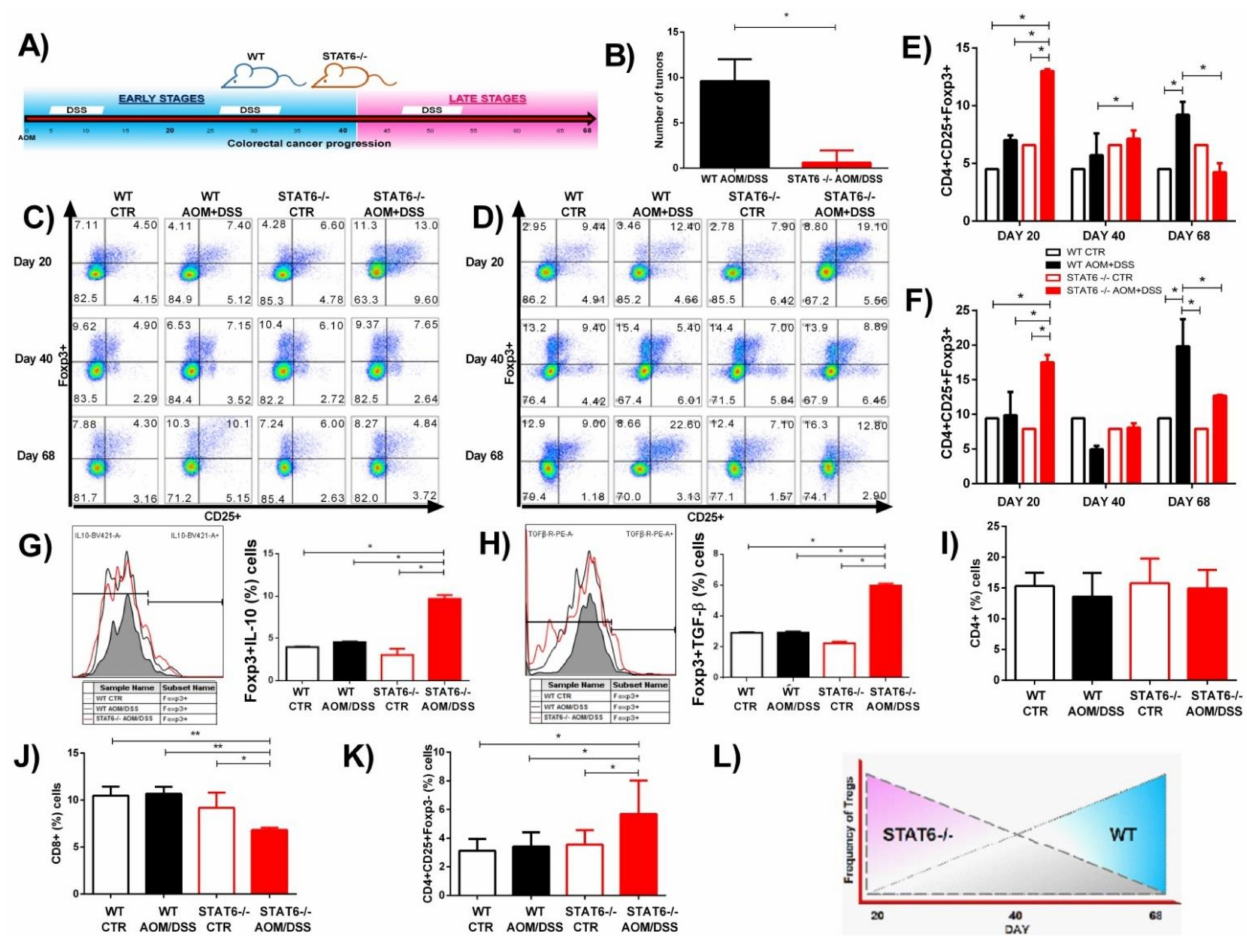
Figure 1. STAT6 − / − animals display twice the percentage of CD4+CD25+Foxp3+ Treg cells during early colitis-associated colorectal cancer (CAC) development. ( A ) Schematic time schedule of azoxymethane (AOM) and dextran sodium sulfate (DSS) administration in WT and STAT6 − / − mice. After the initial AOM injection (12.5 mg/kg), DSS was given in drinking water for 7 days, followed by 14 days of regular drinking water. The mice were sacrificed on Day 20, Day 40 (early tumor development), and Day 68 (late tumor development), after an AOM injection. ( B ) The number of colorectal tumors in the WT and STAT6 − / − mice 68 days after the AOM/DSS administration. The circulating and spleen cells were obtained from the WT or STAT6 − / − AOM/DSS-treated or control mice at the indicated time intervals and were analyzed for the expression of Foxp3 and CD25 in living CD4+ cell populations by flow cytometry. Representative dot plots in total blood ( C ) and in splenocytes ( D ). ( E , F ) The frequencies of CD4+CD25+Foxp3+ cells in the blood ( E ) and splenocytes ( F ). ( G , H ) IL-10 ( G ) and TGF- β ( H ) expressions in CD4+CD25+Foxp3+ cells in the splenocytes of the WT or STAT6 − / − AOM/DSS-treated or control mice. Representative histogram plots are shown, as well as graphs showing the percentages of positive cell populations. ( I – K ) The frequencies of total CD4+ cells ( I ), CD8+ T cells ( J ), and CD4+CD25+Foxp3- (activated cells) ( K ) in the peripheral blood at Day 20. ( L ) The inverse frequency of Treg cells in the WT or STAT6 − / − AOM/DSS-treated animals as CAC progressed. The data are expressed as the mean ± SEM and are representative of two independent experiments with at least three mice per group per day of the analysis. * p < 0.05, ** p <